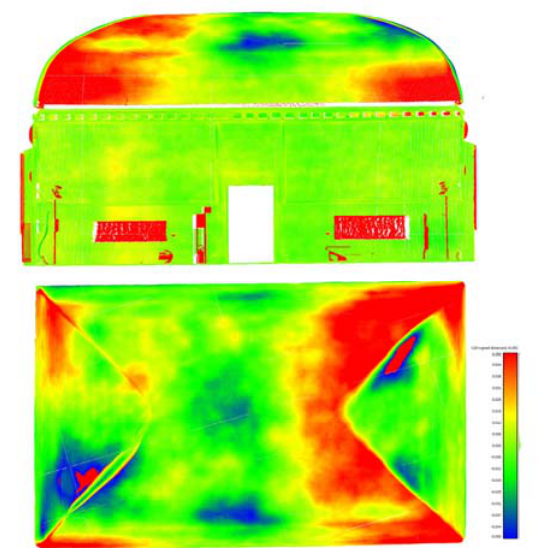
Figure 5: map of model accuracy of different part of the room. On the top a façade, on the bottom a top view of the vault. As evident the biggest modelling errors are in the vault, while in the facades the red parts correspond to decorative elements.